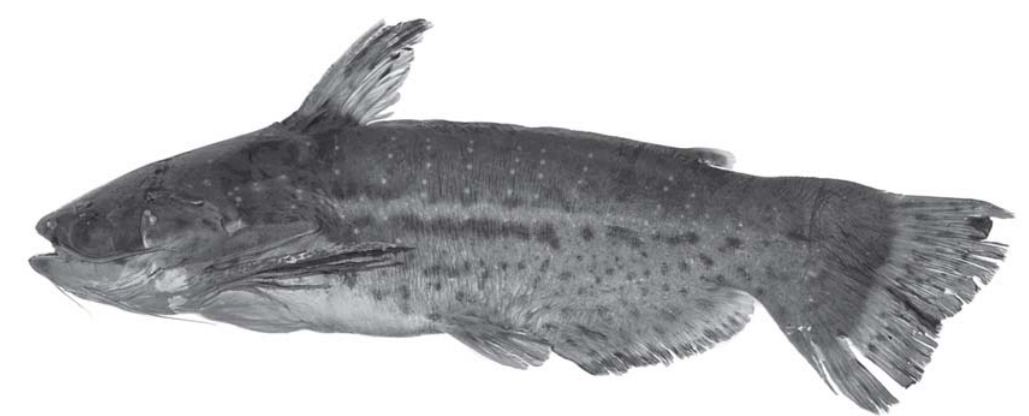
Fig. 8. Auchenipterichthys punctatus , MCNG 42191, 58 mm SL; Venezuela, Amazonas, Caño Candela, near its confluence with río Pasimoni (1°32’06"N,